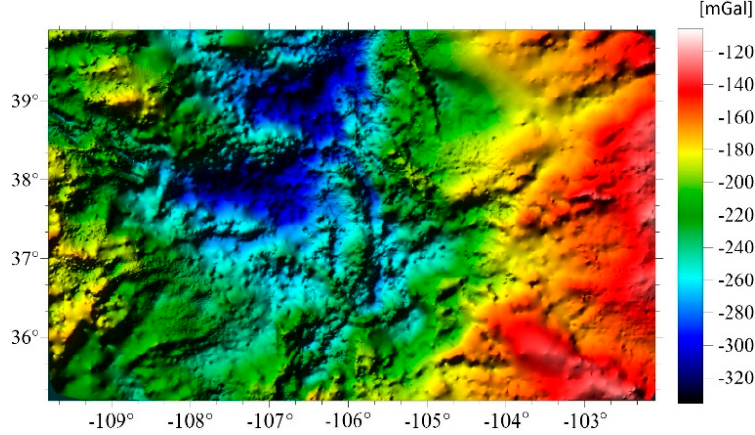
Figure 6. Map of CBA values used for gravity prediction.